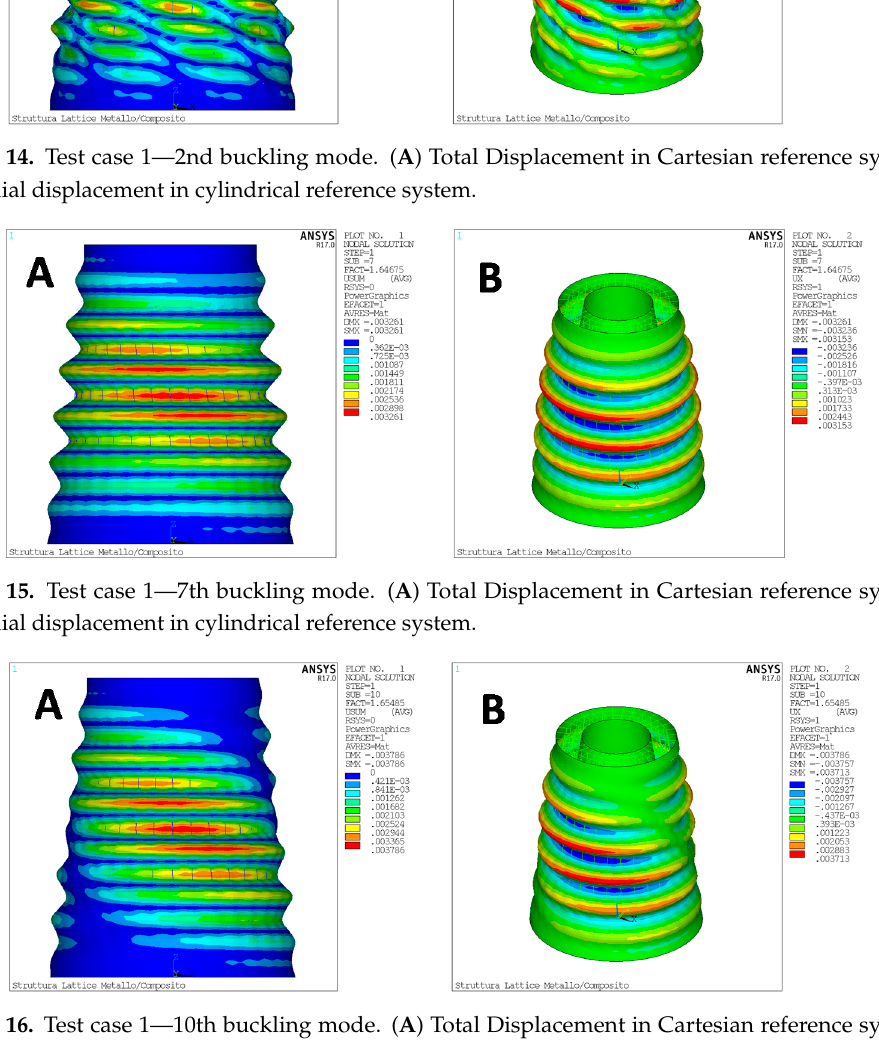
Figure 16. Test case 1—10th buckling mode. ( A ) Total Displacement in Cartesian reference system; ( B ) radial displacement in cylindrical reference system.